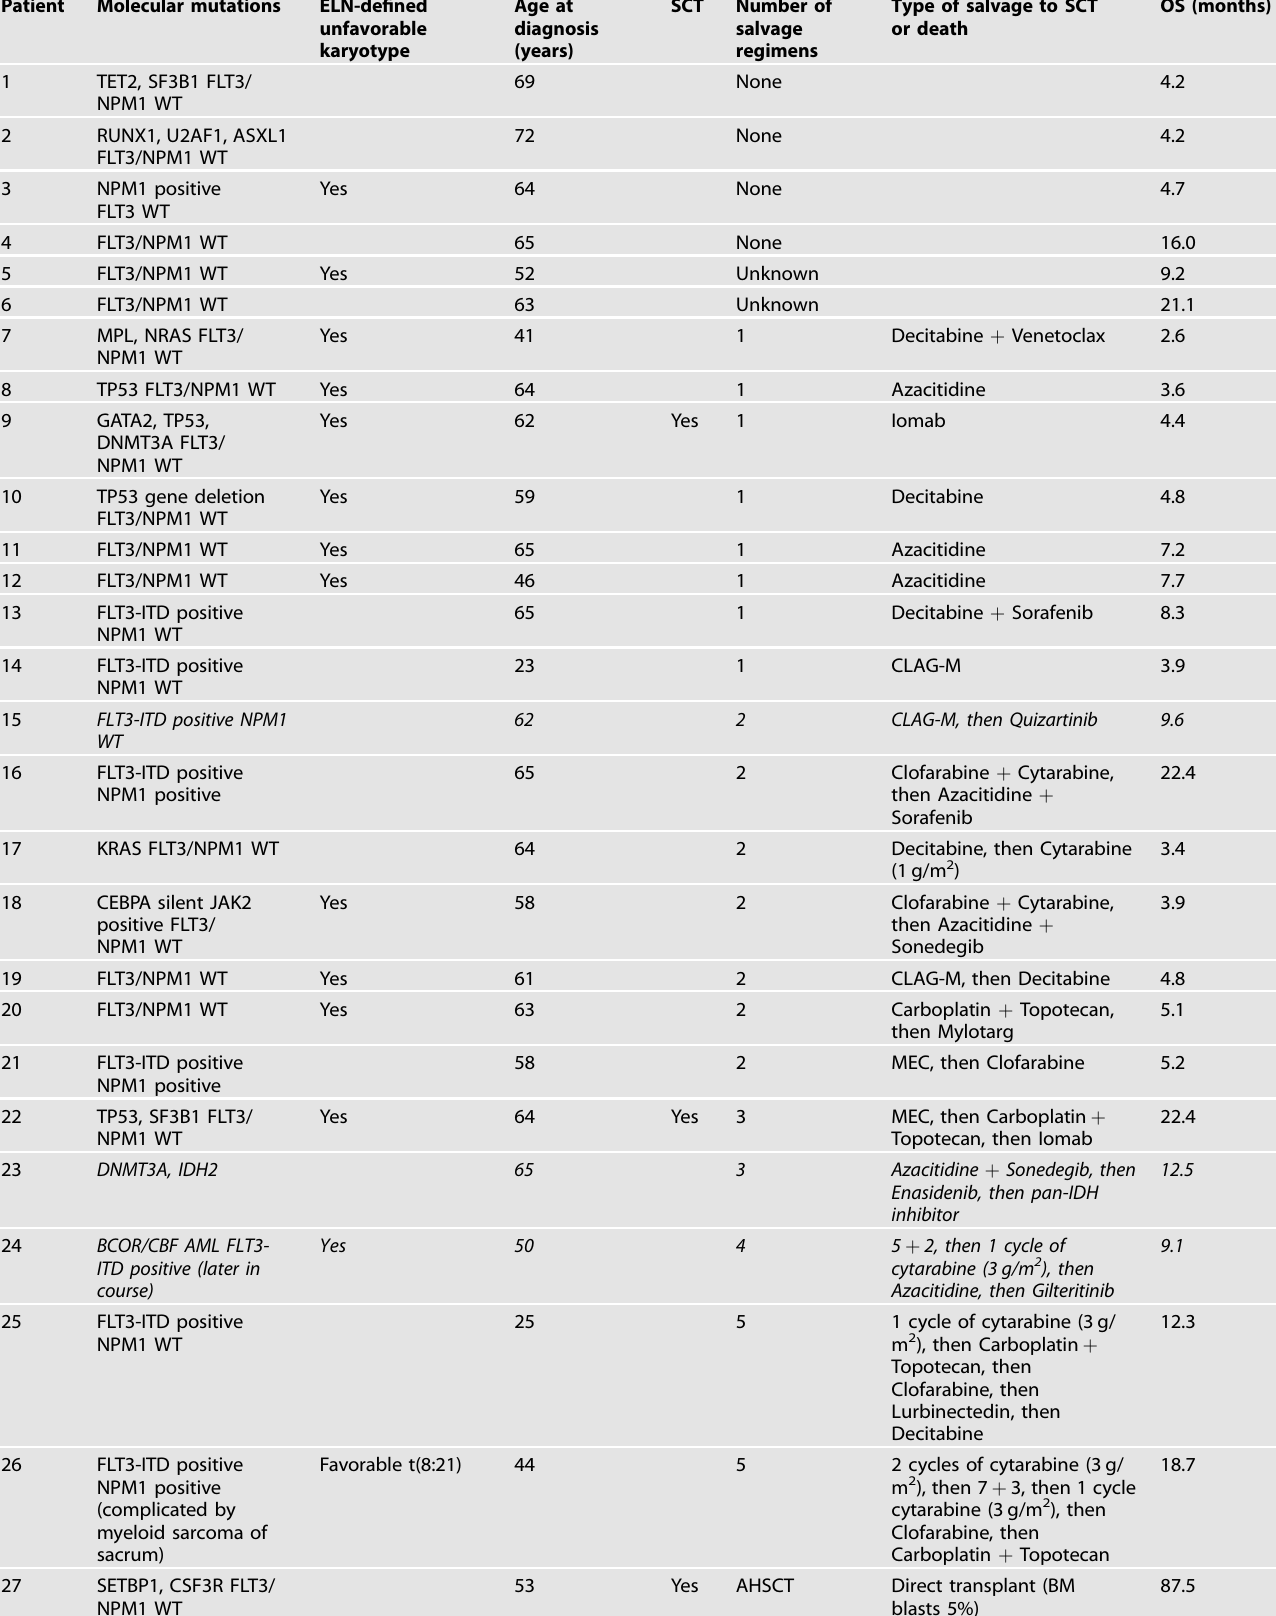
Table 3. Molecular pro fi les and outcomes of 27/47 primary refractory AML patients who received supportive care or documented salvage without